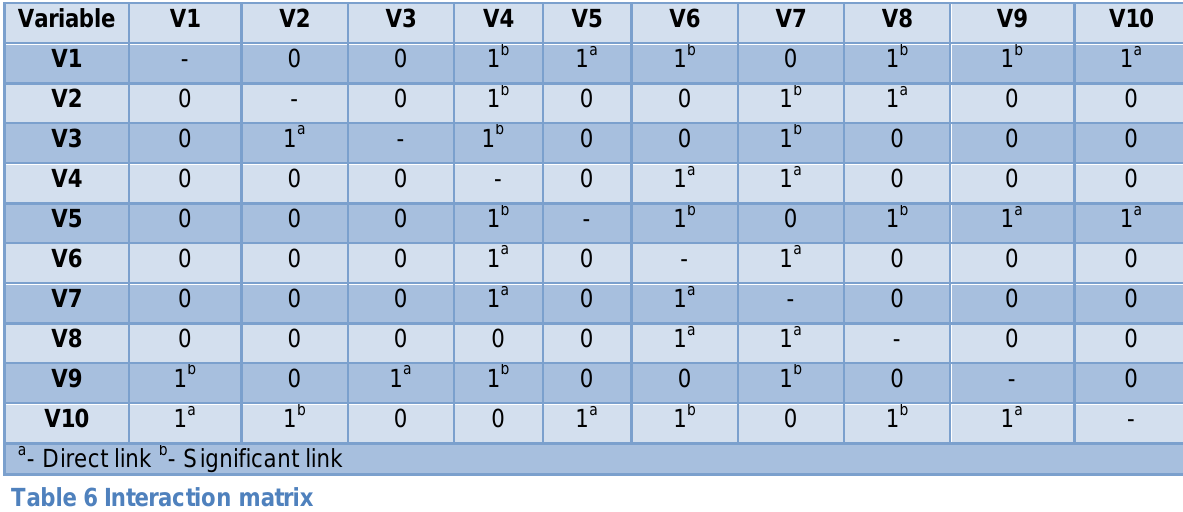
Figure 2 gives the driving power and dependence power of selected factors as obtained from the model. Quadrant I represents autonomous variables, quadrant II represents dependent variables, quadrant III represents linkage variables and quadrant IV represents independent (driver) variables.